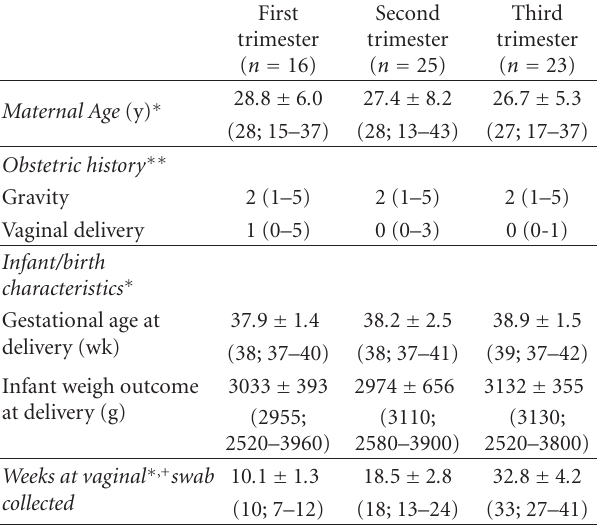
Table 1: Pregnant women and infant-birth characteristics in each trimester of study.